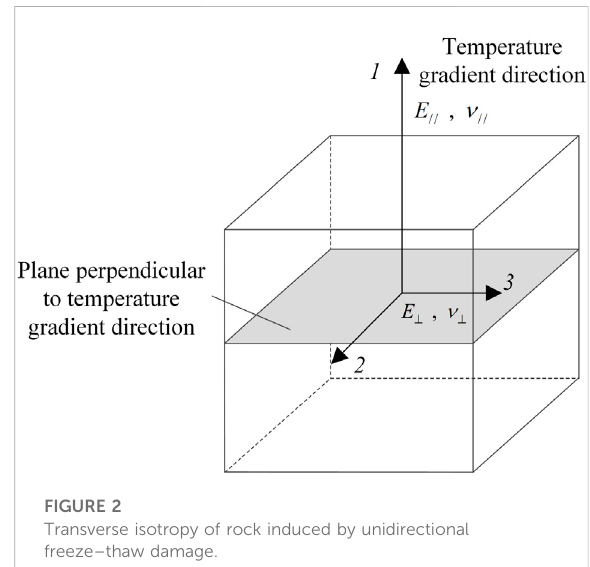
FIGURE 1 Crack distribution in rock induced by unidirectional freeze – thaw damage.